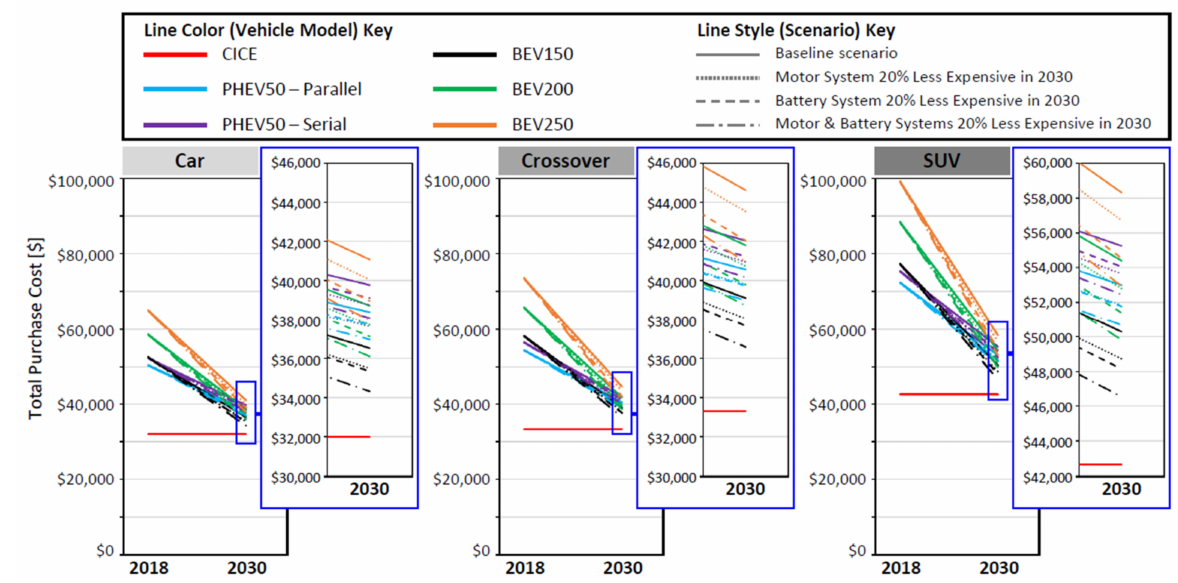
Figure 3. Purchase cost sensitivity analysis for various 2030